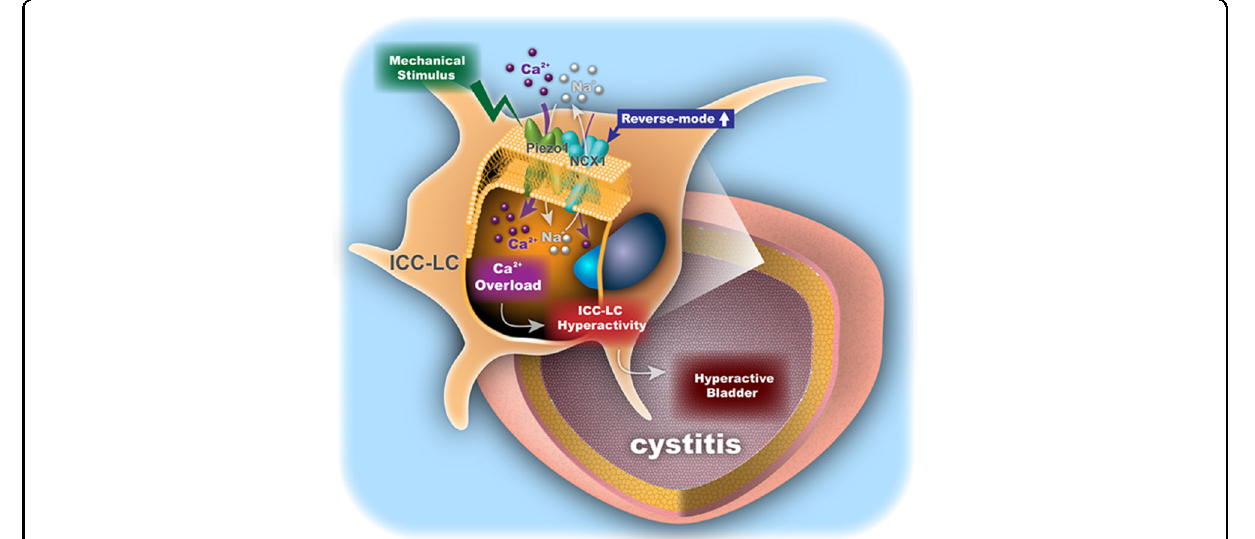
Fig. 8 Schematic representations of the functional roles of the Piezo1 channel and NCX1 in CYP-induced chronic cystitis. In CYP-induced chronic cystitis, when the Piezo1 channel in bladder ICC-LCs was activated by mechanical stimuli (including stretch and hypotonic stress), robust Ca 2 + and Na + in fl ux was consequently triggered in bladder ICC-LCs. In addition, the Piezo1 channel functionally interacted with the relatively activated reverse NCX1 activity in bladder ICC-LCs. As a result, three cytosolic Na + ions permeated through the Piezo1 channel and were extracted from the bladder ICC-LCs through reverse NCX1 activity in exchange for bringing one Ca 2 + ion into the cytoplasm. The synergistic effects of the Piezo1 channel and NCX1 signi fi cantly elevated [Ca 2 + ] i and led to Ca 2 + overload in bladder ICC-LCs, which may consequently result in ICC-LC hyperactivity